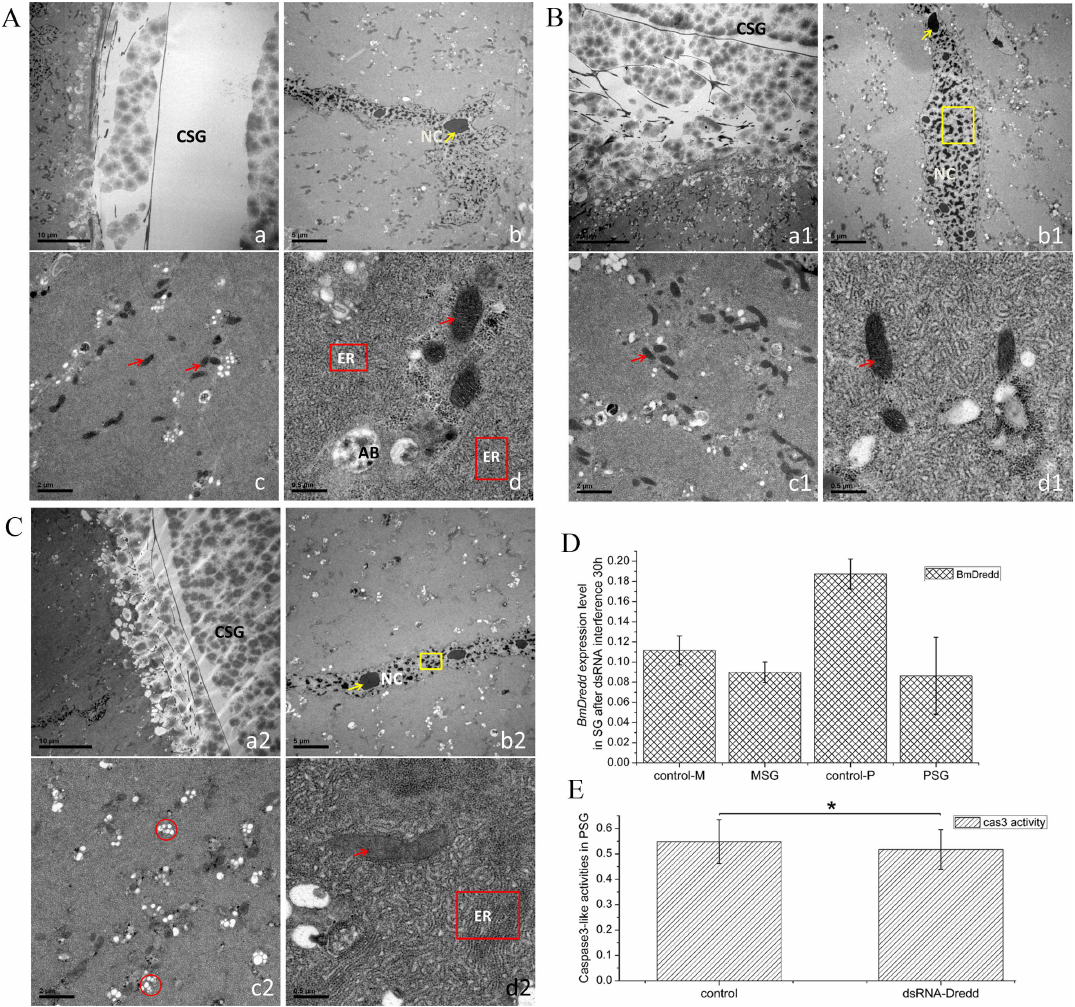
Fig 3. TEM of the SG during the middle of the spinning stage. (a), (a1) and (a2): cavity of SG (CSG). (b), (b1) and (b2): nucleus of SG. (c to c2) and (d to d2): cytoplasm. Yellow arrows in b, b1 and b2: condensedchromatin, yellow frames in b1 and b2: dispersedchromatin. Red arrows in c, c1, and d to d2: mitochondrion, red frames in d and d2: endoplasmic reticulum (ER), red circles in c2: golgi apparatus.AB: apoptosisbody. A: ControlSG injectingwith dsRNA-EGFP at L5D7. B: dsRNA injected duringthe middleof the fifth instar (about middle of L5D6). C: dsRNA injectedduringlate stage of the fifth instar (about early wandering).D: BmDredd expressionlevels in SG at 30 h post- BmDredd interference.E: Caspase3-like activities in PSG after dsRNA treatments for about 30 h, P <